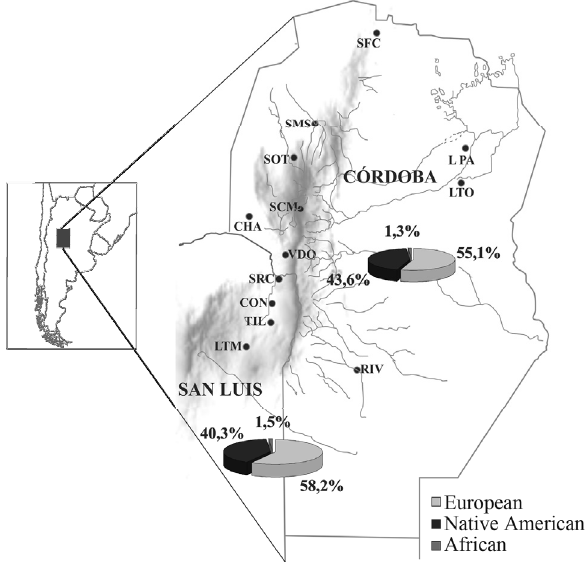
Figure 1 - Approximate area of the Sierras Centrales region of Argentina and sampling locations, with ancestry contributions estimated based on the populations of Córdoba and San Luis. SMS, San Marcos Sierras; LTO, La Tordilla; SFC, San Francisco del Chañar; SCM, San Carlos Minas; LPA, La Para; VDO, Villa Dolores; SOT, Villa de Soto; CHA, Chancaní; RIV, Río Cuarto; TIL, Tilisarao; SRC, Santa Rosa de Conlara; CON, Concarán; LTM, La